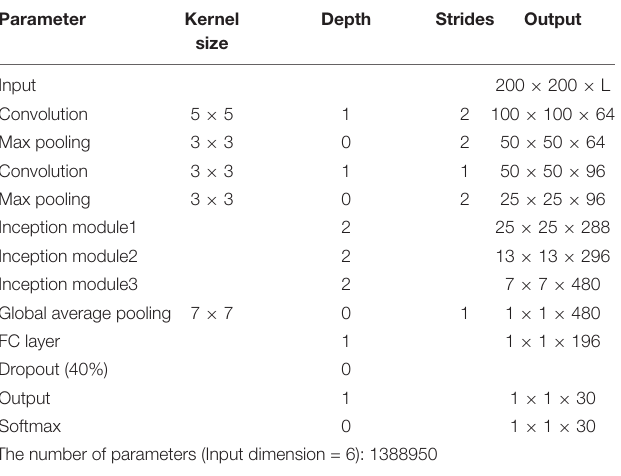
TABLE 2 | Detailed network parameters of the proposed lightweight CNN model. TABLE 3 | A summary of the manual and automatic approaches